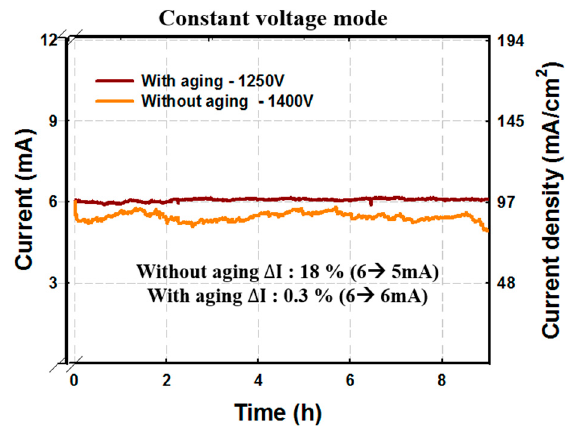
Figure 10. Comparison of stability with and without electric aging. Electrically aged emitters were shown to be more stable.